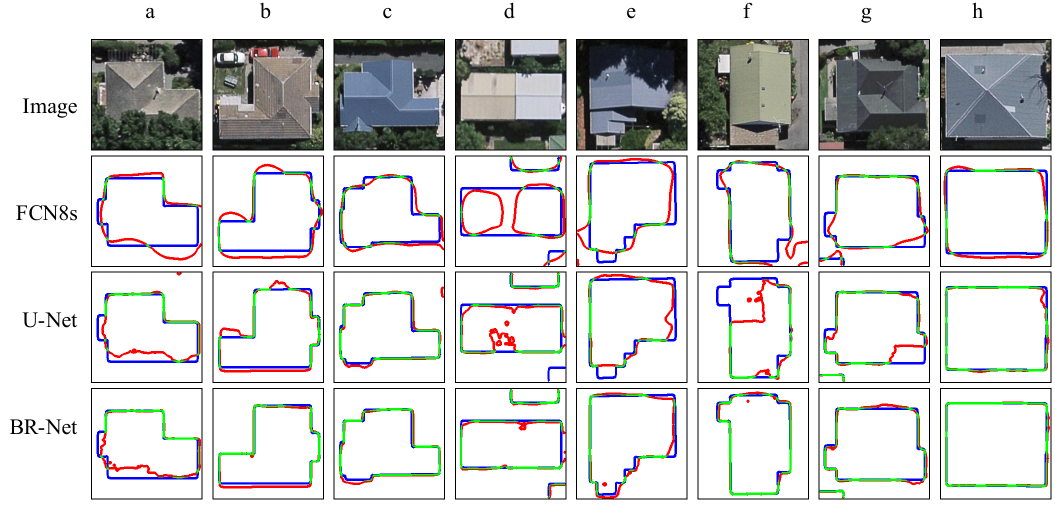
Figure 9. Representative results of single-building-level outline extraction by FCN8s, U-Net and, BR-Net. The green, red, blue, and white channels in the results represent true positive, false positive, false negative, and true negative predictions,